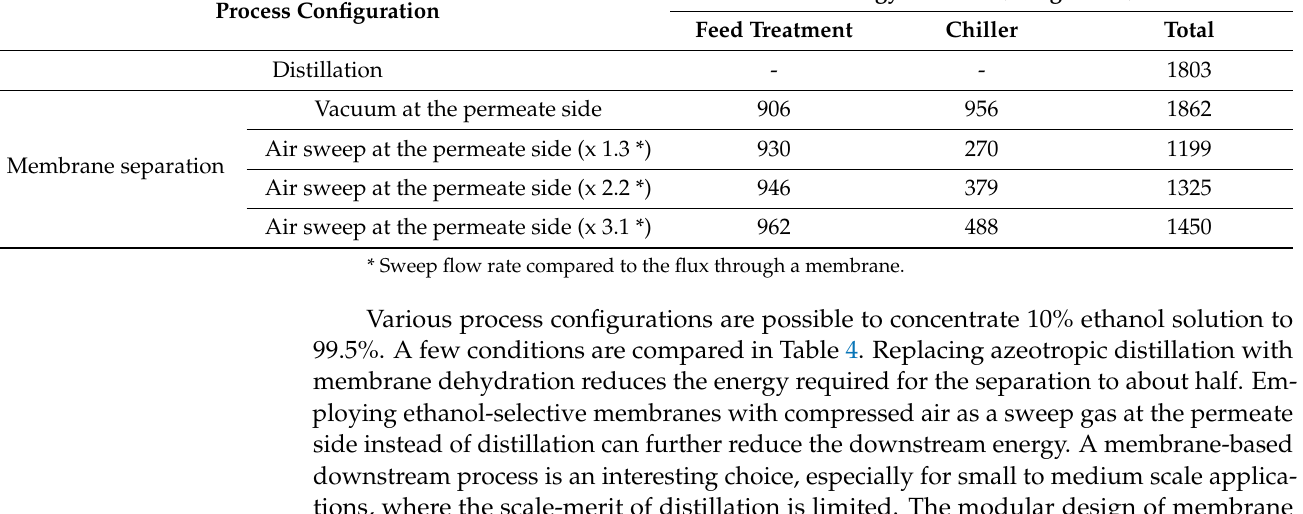
Table 3. Comparison of the energy required to concentrate 10 wt% ethanol to 80 wt%. Process Configuration